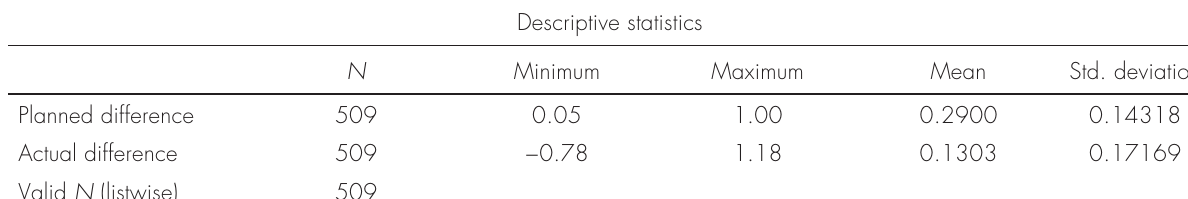
Table IV. Teeth in pilot study of 40 cases for which no IPR was done, to show variation of New CC Pro measurements from T1 to T2.